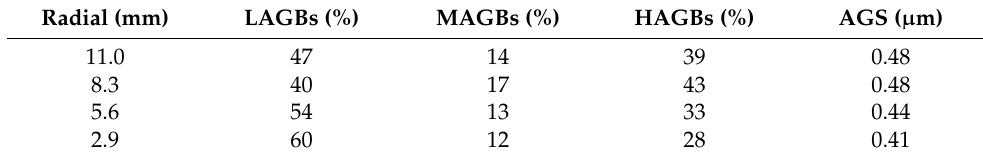
Table 3. Grain boundary fraction and AGS of the forged tube with a reduction of 42.7%.